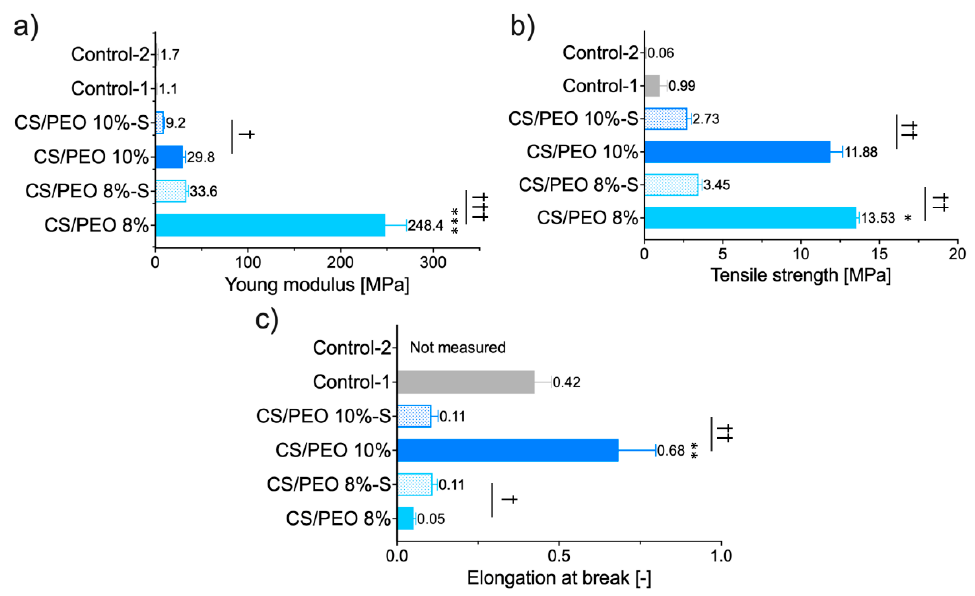
Figure 4. Mechanical properties of CS/PEO nanofibers before and after S-coating as compared to commercial wound dressings (Control-1; Control-2): ( a ) Young modulus, ( b ) tensile strength, and ( c ) elongation at break (mean ± S.D.; n = 5). Since the Control-2 sample was delicate in structure, the constant value of deformation (2 mm) was applied to estimate its Young modulus and tensile strength. * represents significant differences with p ≤ 0.05, while ** and *** represents significant differences with p ≤ 0.01 and p ≤ 0.001 between uncoated formulations; †, †† and ††† symbolize significant differences with p ≤ 0.05, p ≤ 0.01 and p ≤ 0.001 between uncoated and S-coated nanofibers, respectively.